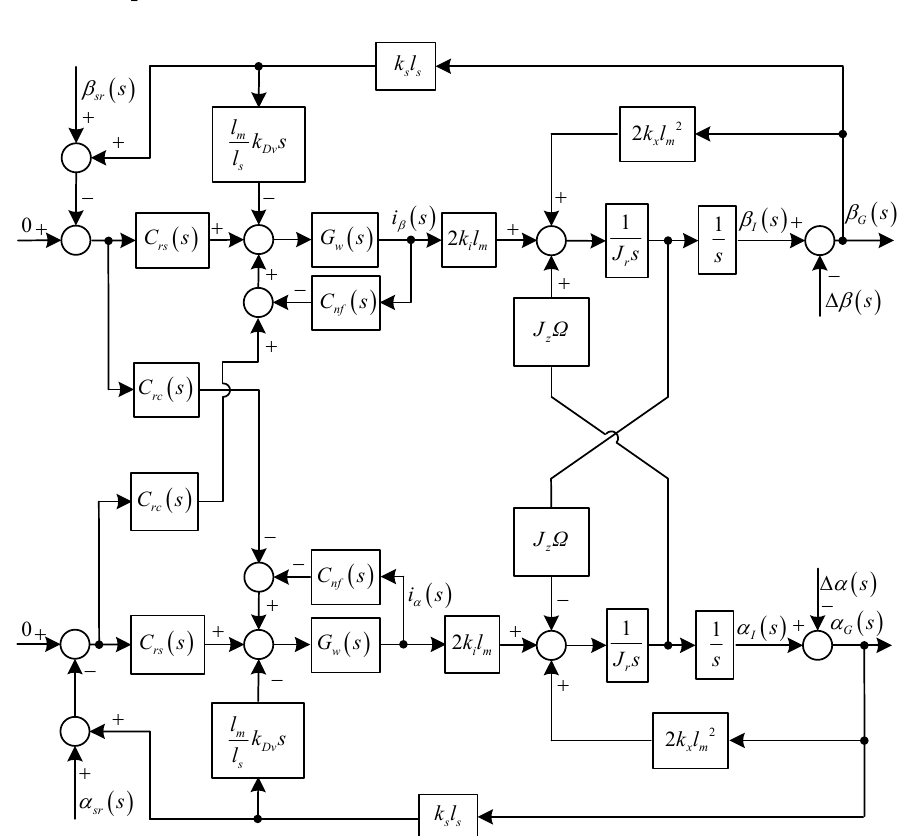
Figure 7. Diagram of the rotational subsystem with two variable-phase notch feedback